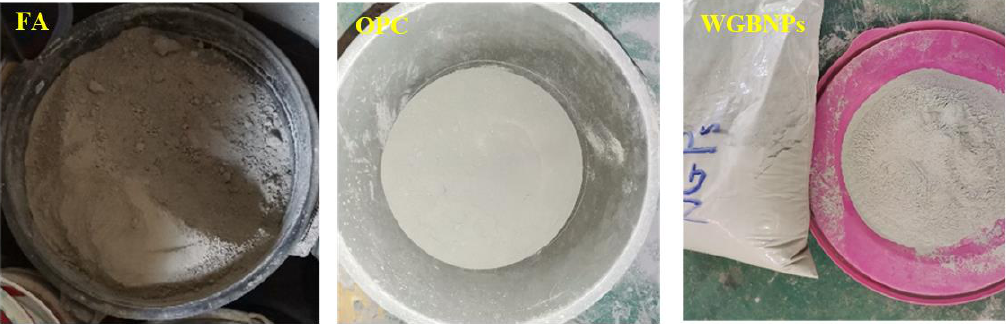
Figure 1. Raw material-based concrete binder.